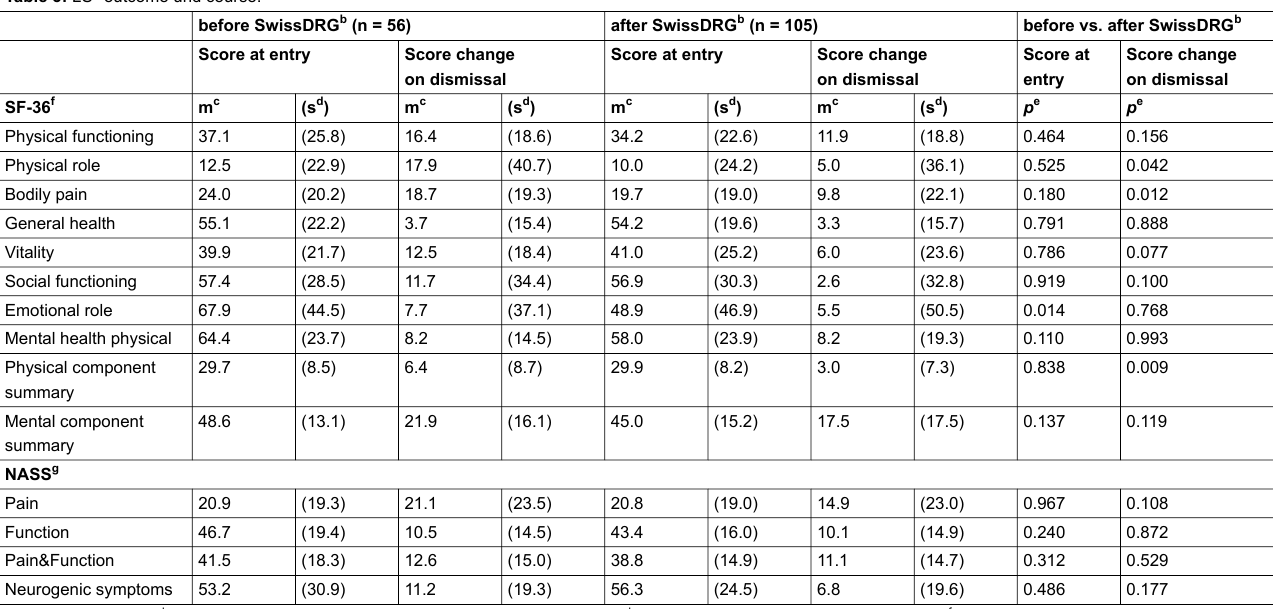
Table 3: LS a outcome und